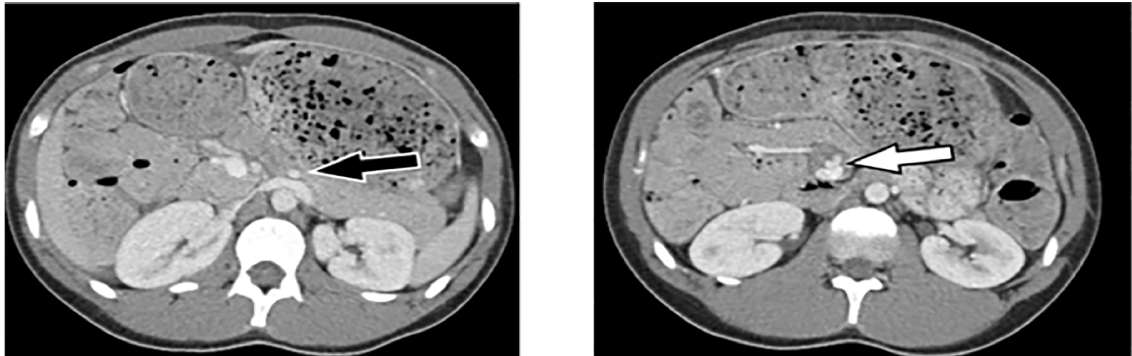
Image 1. Left-hand image showing branch point of the superior mesenteric artery from the abdominal aorta on axial computed tomography views (black arrow). Right-hand image showing “whirlpool” sign (white